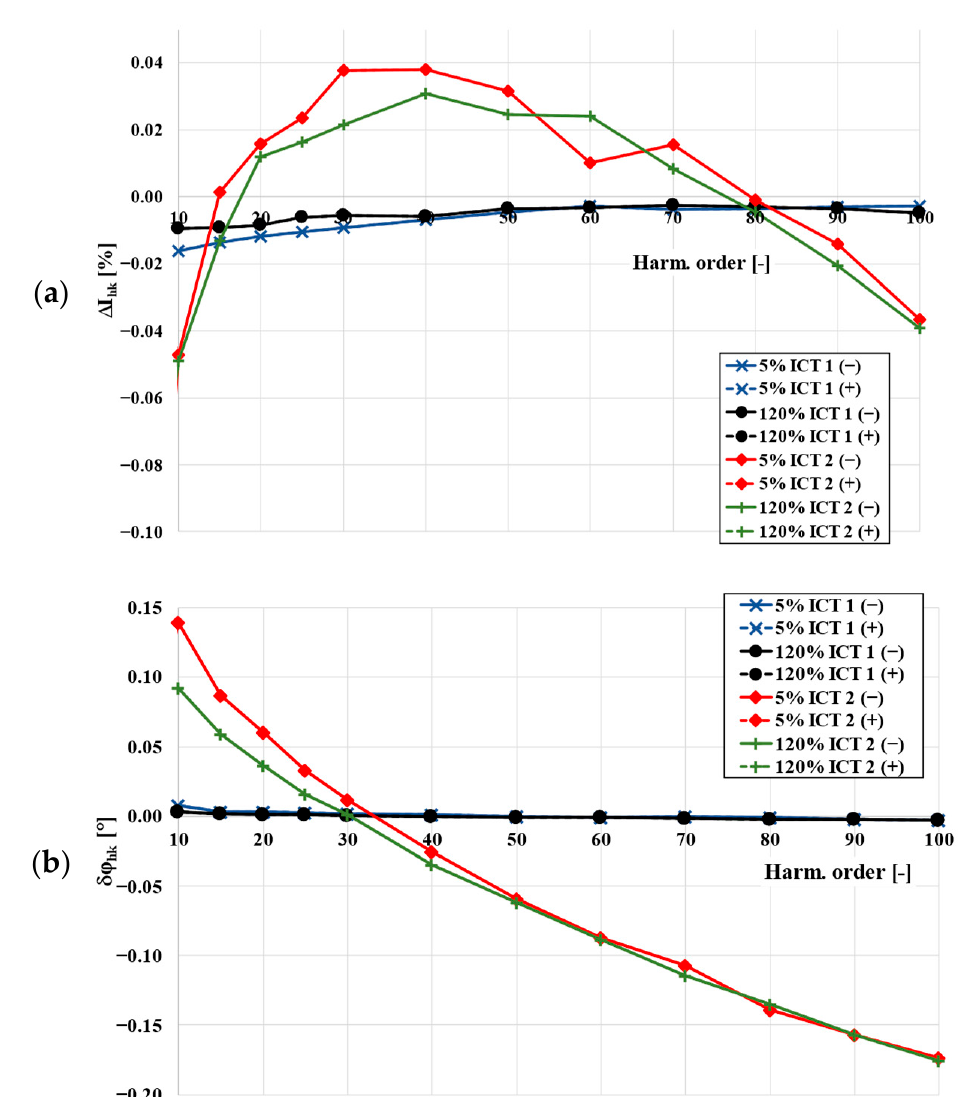
Figure 4. Comparison of determined values of the current error ( a ) and phase displacement ( b ) for both tested CTs up to 100th higher harmonic and rated load of the secondary winding. In the frequency range of harmonics from order 11th to 100th, ICT 1 also shows significantly better metrological performance than tested ICT 2 . The only difference between these CTs is that ICT 1 is made from a magnetic core characterized by doublet thickness of the used magnetic material Ni80Fe20. In contrast, ICT 2 is made from a magnetic core made from transformer steel [27–29]. Presented results indicate that proper magnetic material and oversized magnetic core may ensure high transformation accuracy of distorted current, including the irrelevant values of the self-generated harmonics. In Figure 5, the comparison of determined values of current error and phase displace- ment for both tested CTs up to 10th higher harmonic, and 25% of the rated load of the secondary winding is